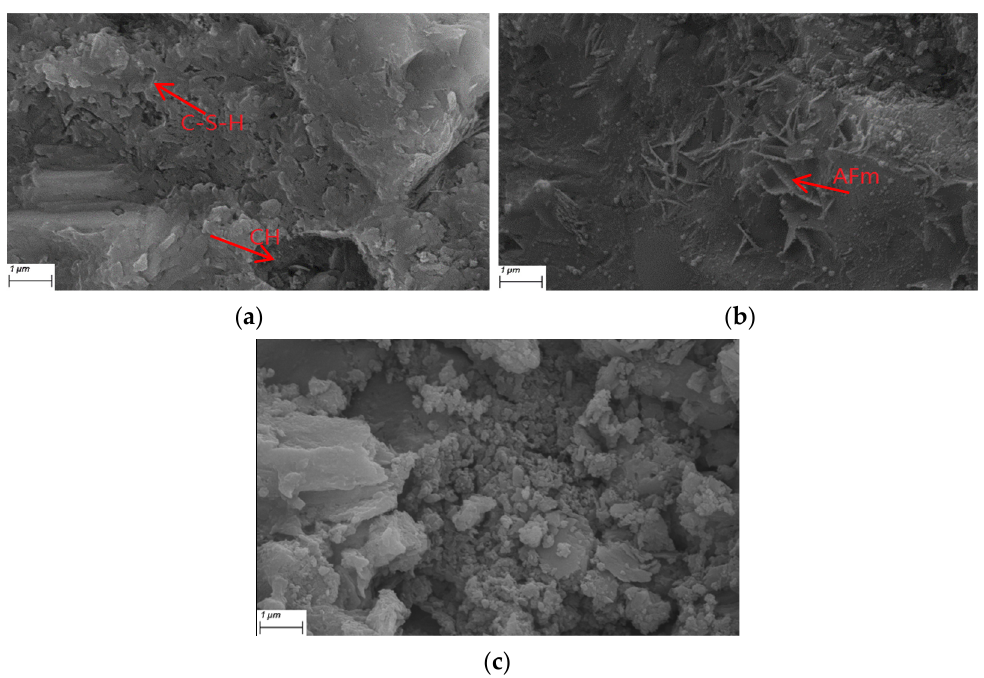
Figure 8. SEM micrographs of the cement-based materials with different contents of NSN at 28 d. ( a ) N5 without NSN. ( b ) N7 with 0.16% content of NSN. ( c ) N8 with 0.24% content of